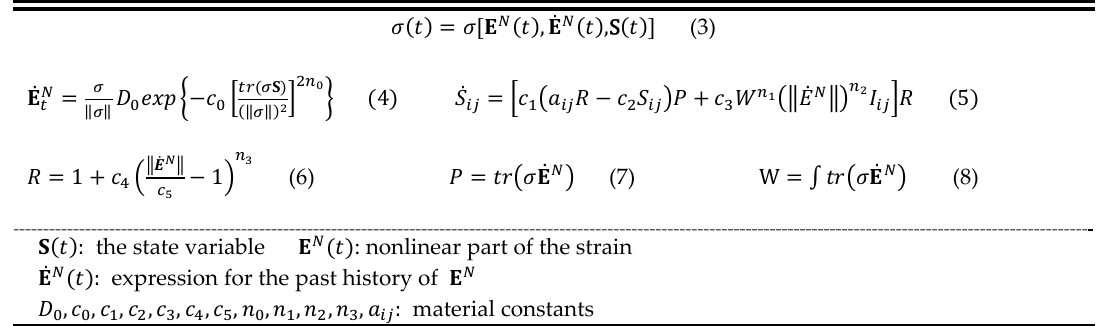
Table 2. This table shows the constitutive equations for MAT_083 [8]. Material constants in Table 2 are identified based on s-s curves [11,12].